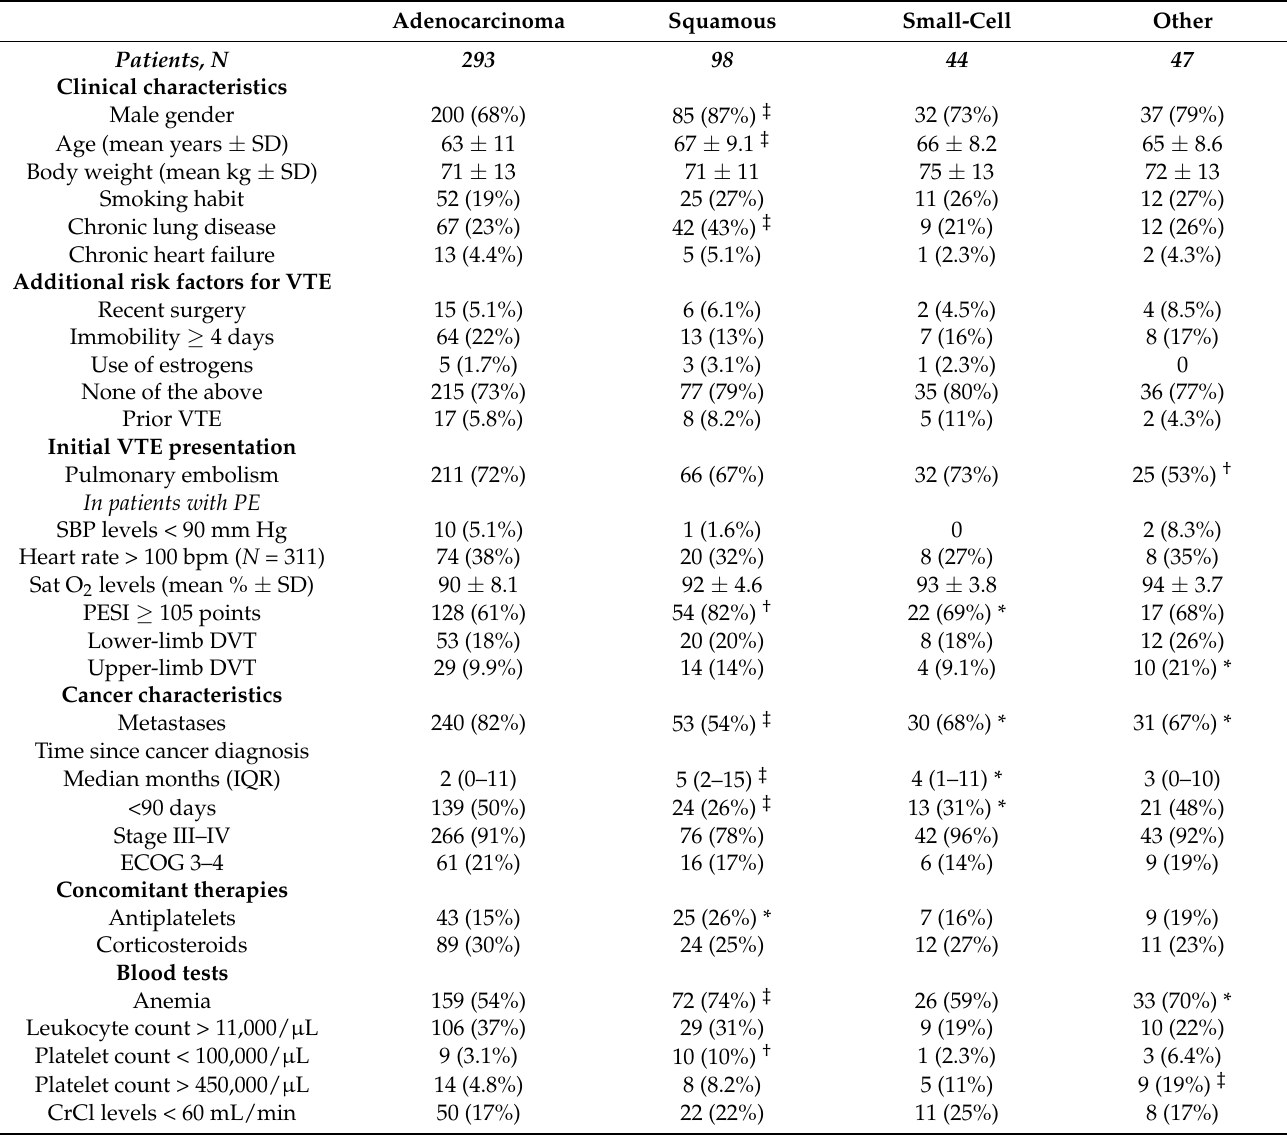
Table 1. Clinical characteristics of the patients, according to the histology. Adenocarcinoma Squamous Small-Cell